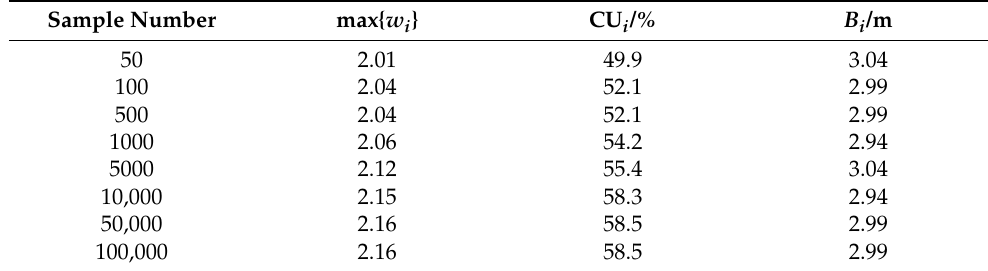
Table 3. The optimal evaluation index w i ( j ) with uniformity coefficient CU i and spraying width B i under different sample numbers.